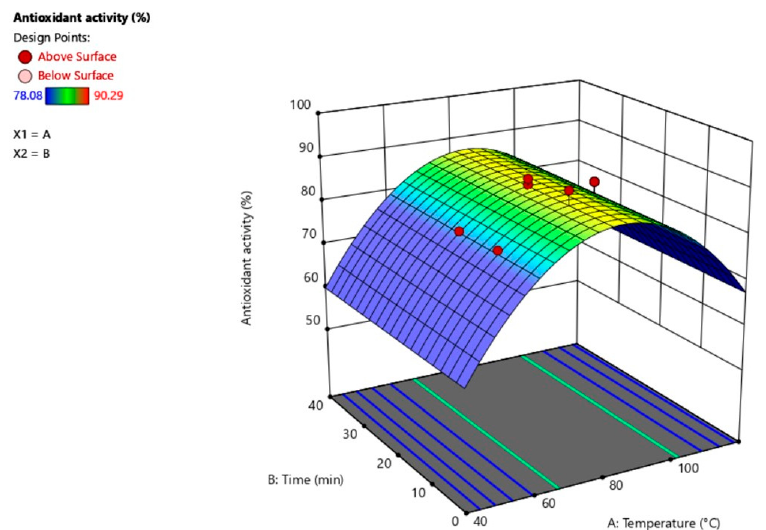
Figure 2. Three-dimensional response surface of antioxidant activity of oregano extract with respect to temperature and time.